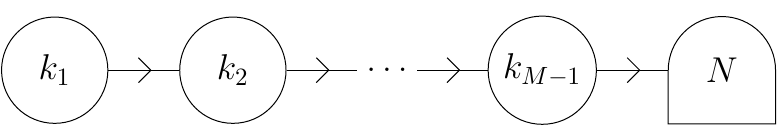
Figure 1 . The quiver which describes the generic surface operator in pure SU( N ) gauge